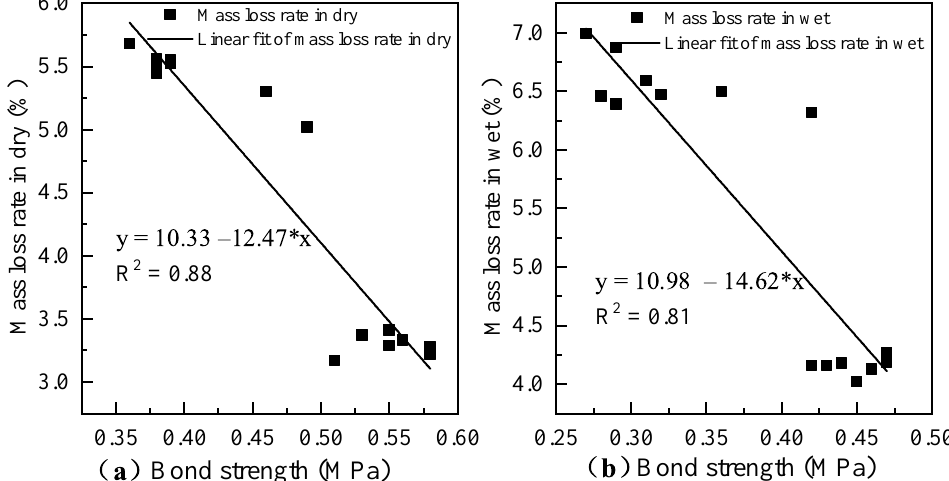
Figure 7. The relationship between mass loss rate and bond strength of mixture: ( a ) masss loss rate in dry, and ( b ) mass loss rate in wet.